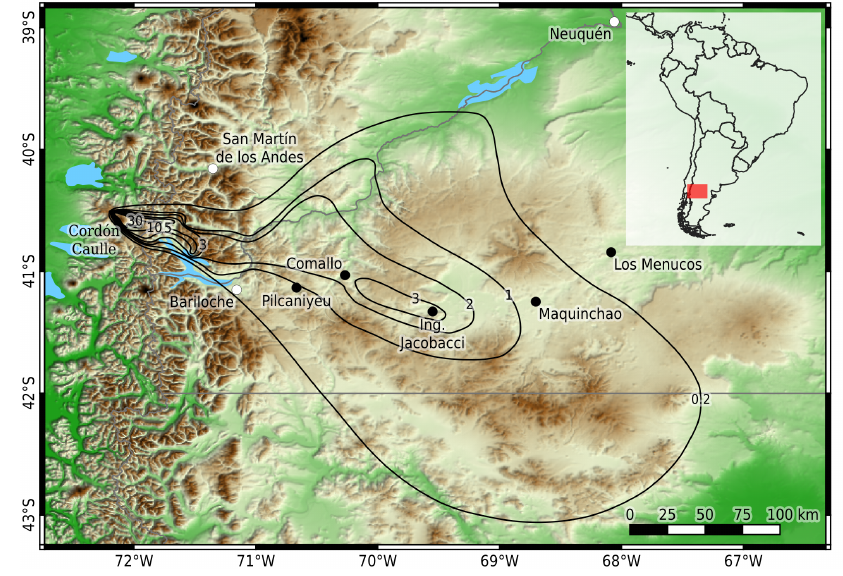
Figure 2. Map of the study region with the main localities of the Patagonian steppe affected by the tephra fallout following the 2011 CC eruption. The isopach map of Unit III of the associated tephra-fallout deposit is also indicated with the thickness contours in centimetres (adapted from Dominguez et al. [26]). Elevation data extracted from the Global Multi-resolution Terrain Elevation Data 2010 (GMTED2010)